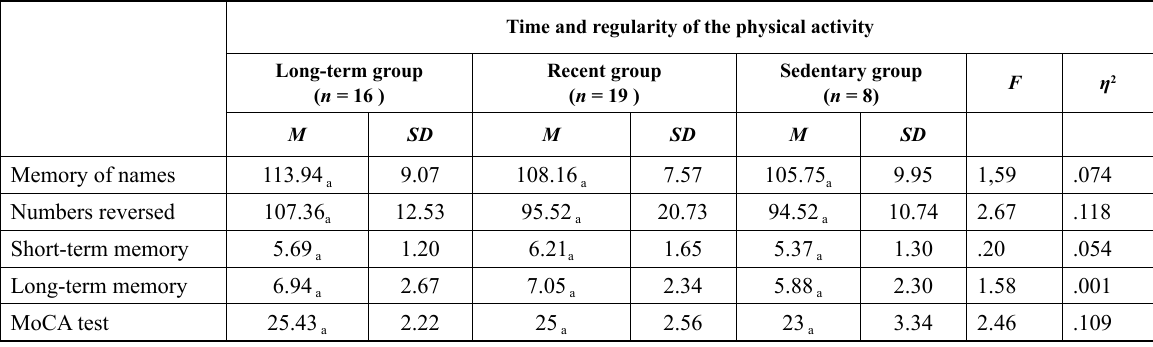
Table 2. Descriptive characteristics and inferential statistics of the results from memory tests and MoCA